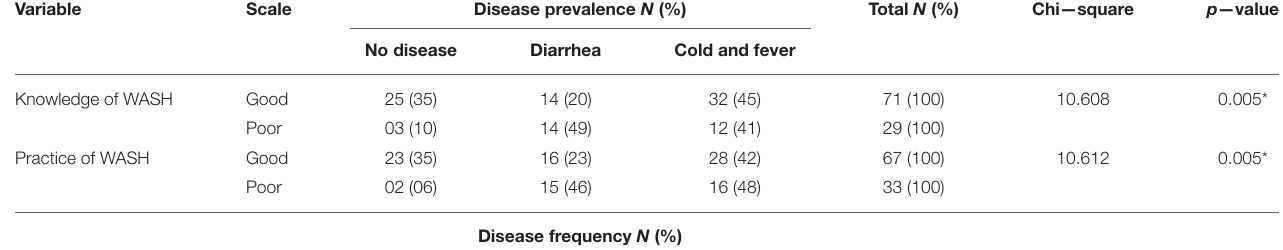
TABLE 2 | Association of children’s prevalence of disease with mother’s WASH knowledge and practice.